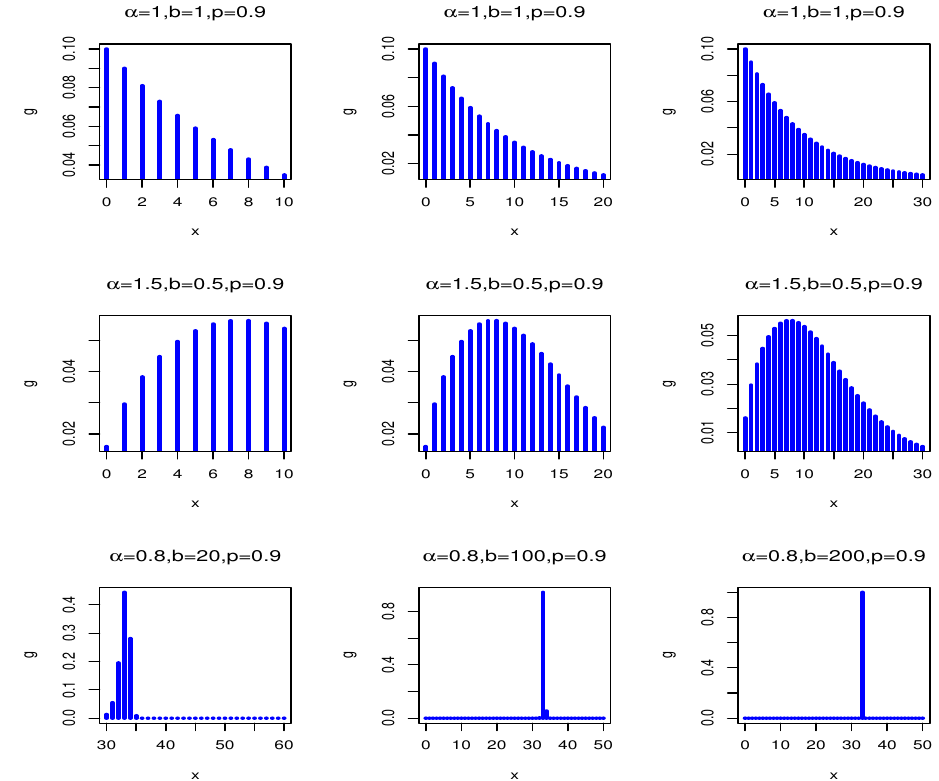
Figure 1. pmfs of the DWMOE ( α , b , ρ ) distribution for some parameter